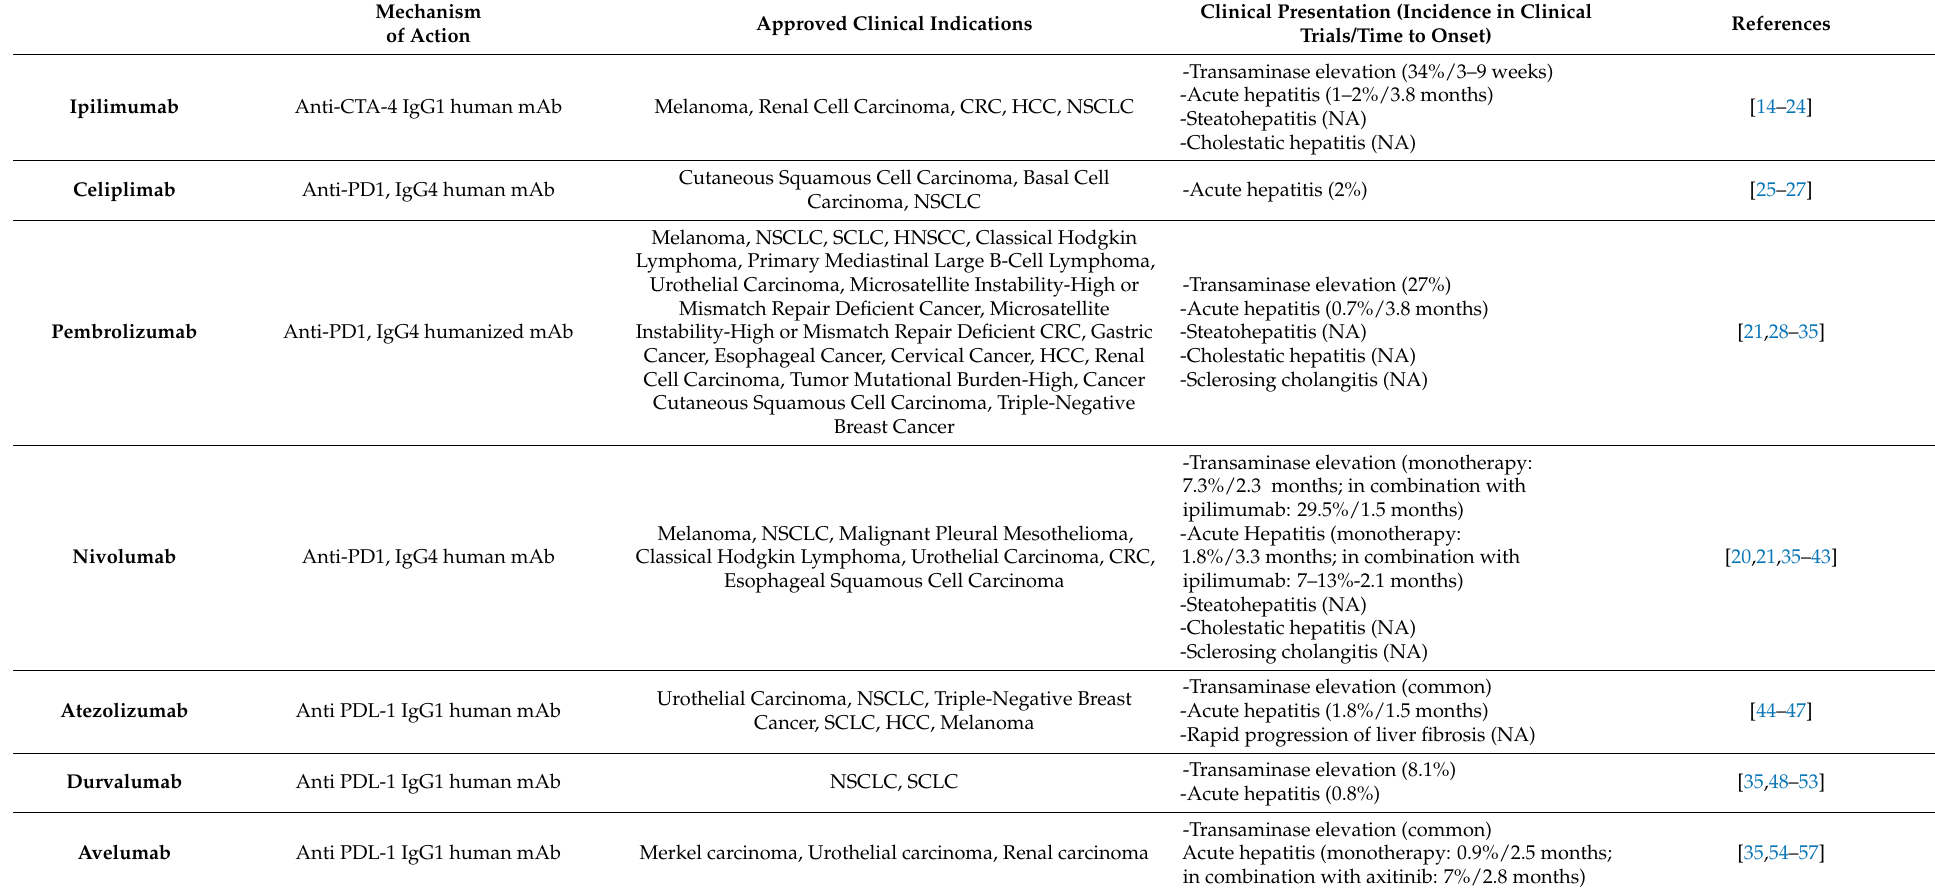
Table 1. Hepatotoxicity of the approved immune checkpoint